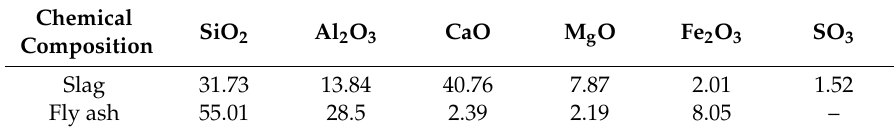
Table 2. Chemical composition of fly ash and slag